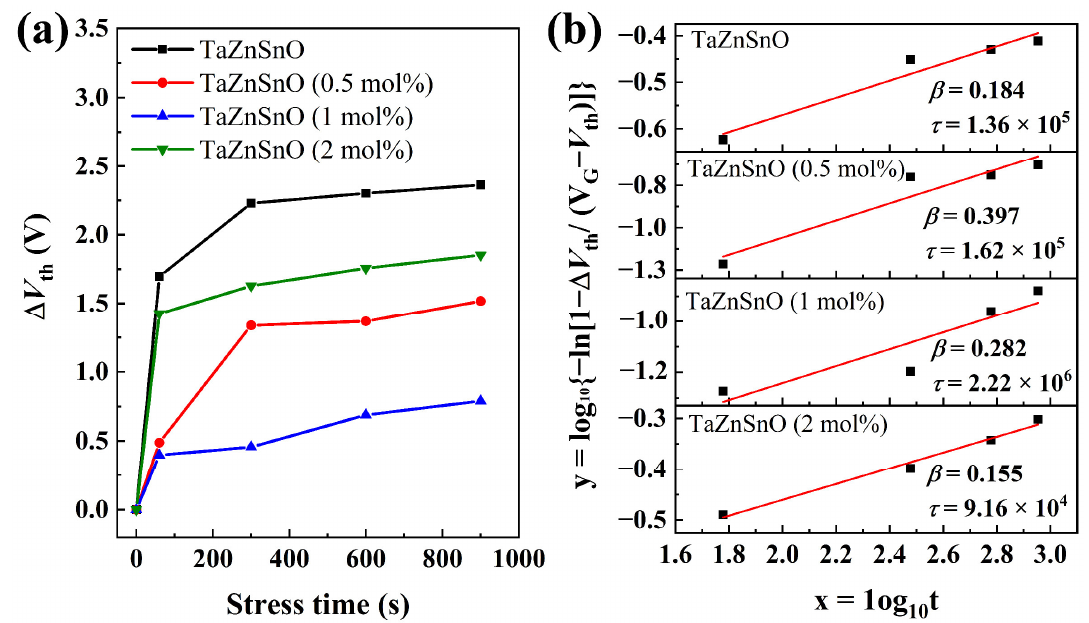
Figure 6. ( a ) The dependence of Δ V th on stress time and ( b ) the fitted curves described by Equation (7) for the TaZnSnO TFTs with Ta 5+ doping of 0, 0.5, 1, and 2 mol%, respectively.